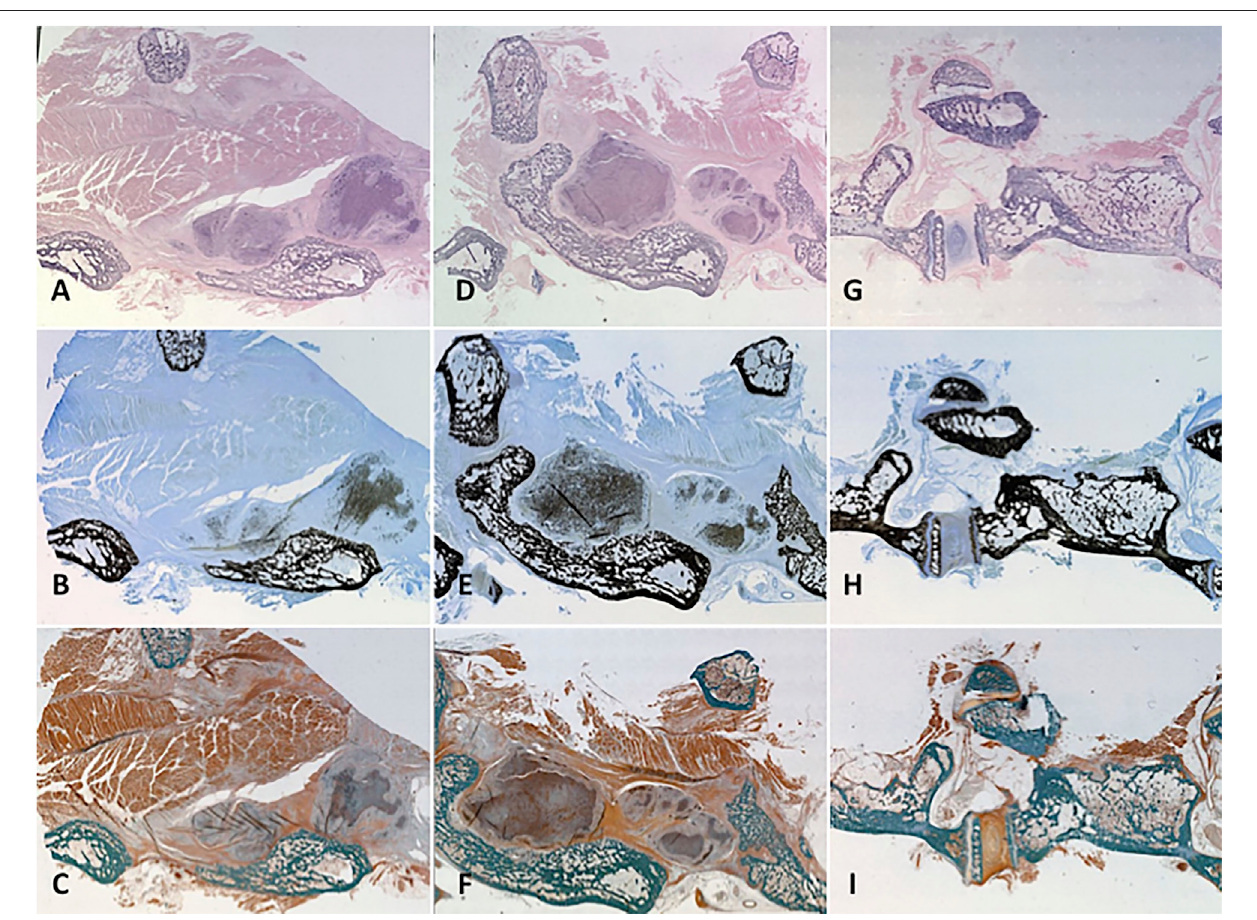
FIGURE 7 | Histology. Representative specimens were evaluated for cellularity and mineralized tissue using three different stains. Cellularization of the remodelled scaffold with osteoblasts/clasts was signalled by pronounced hematoxylin staining of the treated scaffold on H and E stain to variable degrees according to treatment group (A, D, G) . Mineralized osteoid within the scaffold showed itself as “ peppering ” similar to native bone on Von Kossa-MacNeal ’ s Tetrachrome stain (B, E, H) and similar jade green appearance to native bone on Goldner ’ s Trichrome stain (C, F, I) . Group 1 (A – C) displayed signi fi cant osteoblast recruitment and mineralized osteoid production, but not as much as PRP-treated Group 2 (D – F) . A native control vertebral body-transverse process junction is shown (G – I) for